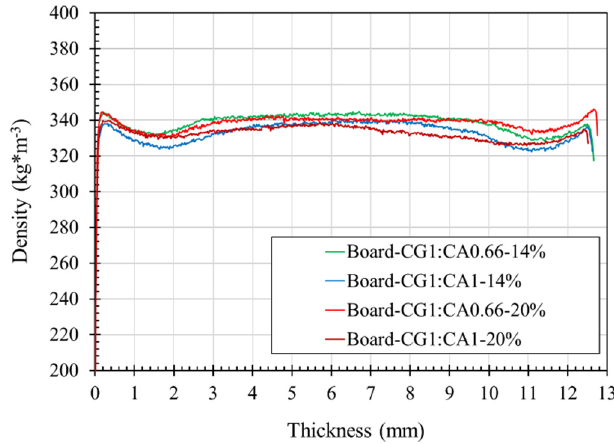
Figure6. Densityprofilesofthewoodfiberinsulationboardsaccordingtothereactantratio(CG1:CA0.66 Figure 6. Density profiles of the wood fiber insulation boards according to the reactant ratio (CG1:CA0.66 and CG1:CA1) and the bio-based adhesive content (14% and 20%).